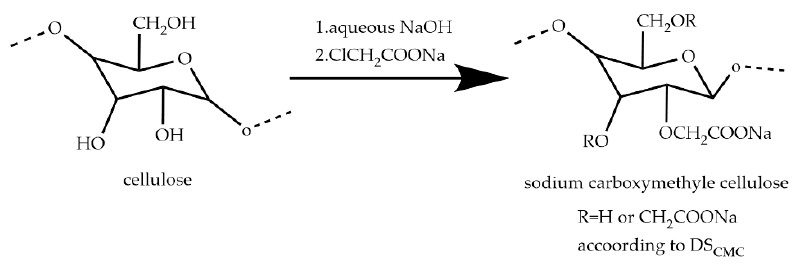
Figure 2. Reaction scheme of the carboxymethylation of cellulose [30].